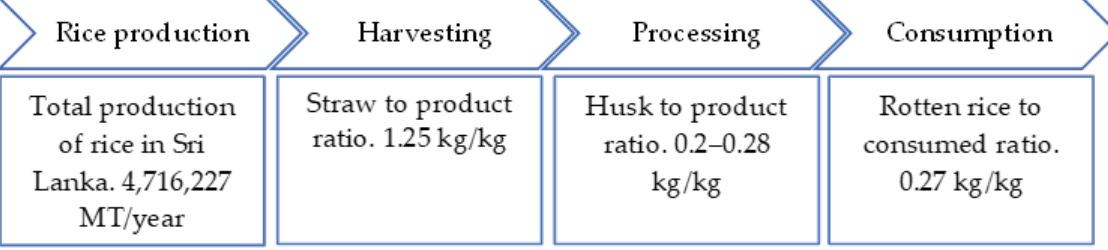
Figure 2. Amount of rice processing by-products throughout the value chain adopted from [24 –